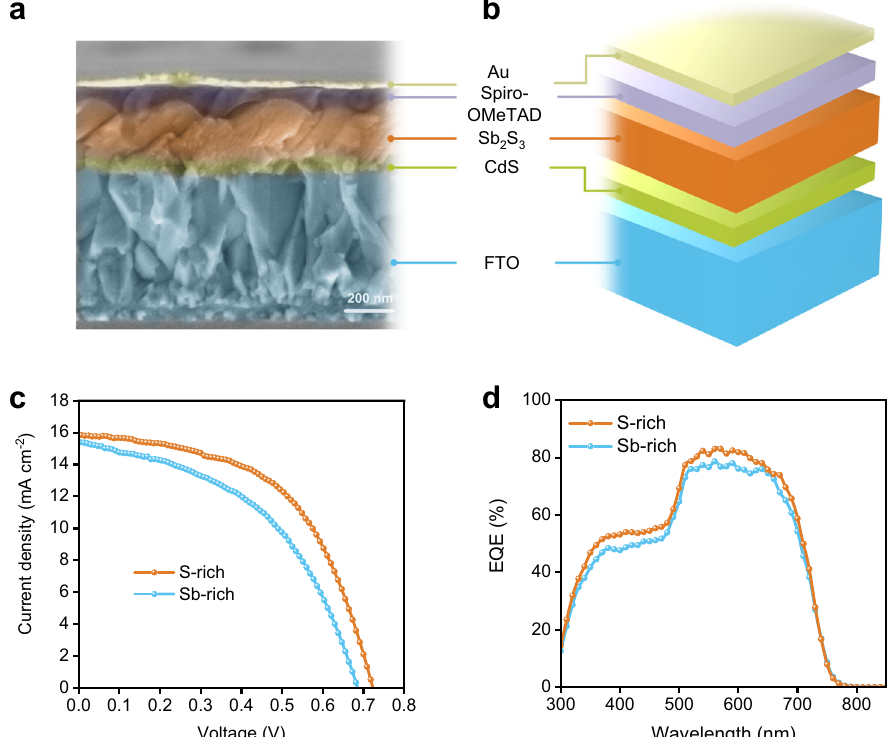
Fig. 3 Device structure and photovoltaic performance. a , b Cross-sectional SEM image and corresponding device con fi guration of Sb 2 S 3 solar cells. c J – V characteristics of the optimal Sb-rich and S-rich Sb 2 S 3 devices under standard one Sun illumination. d EQE spectra of the optimized Sb-rich and S-rich Sb 2 S 3 -based